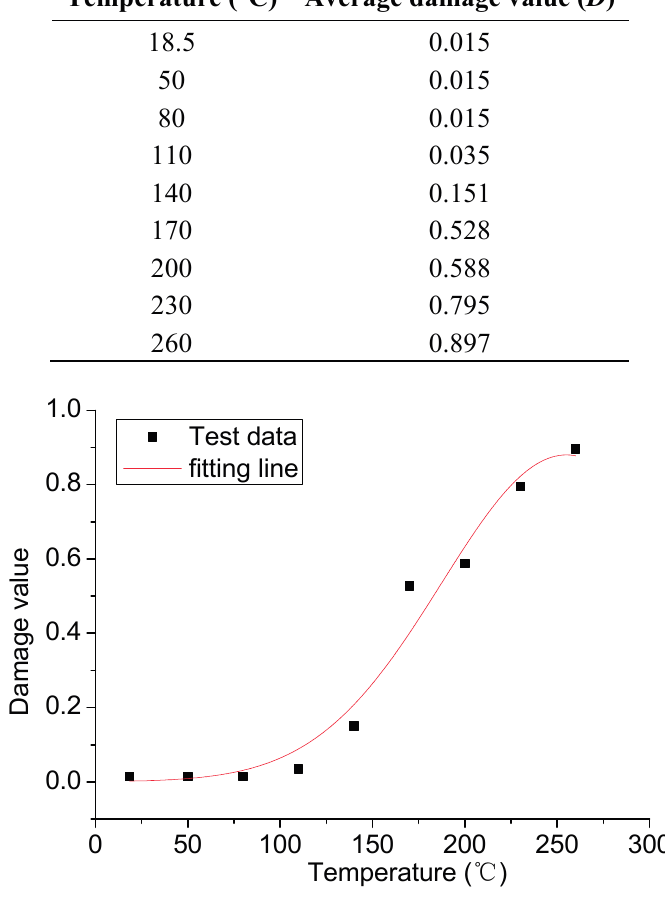
Figure 7. The relation between the temperature and